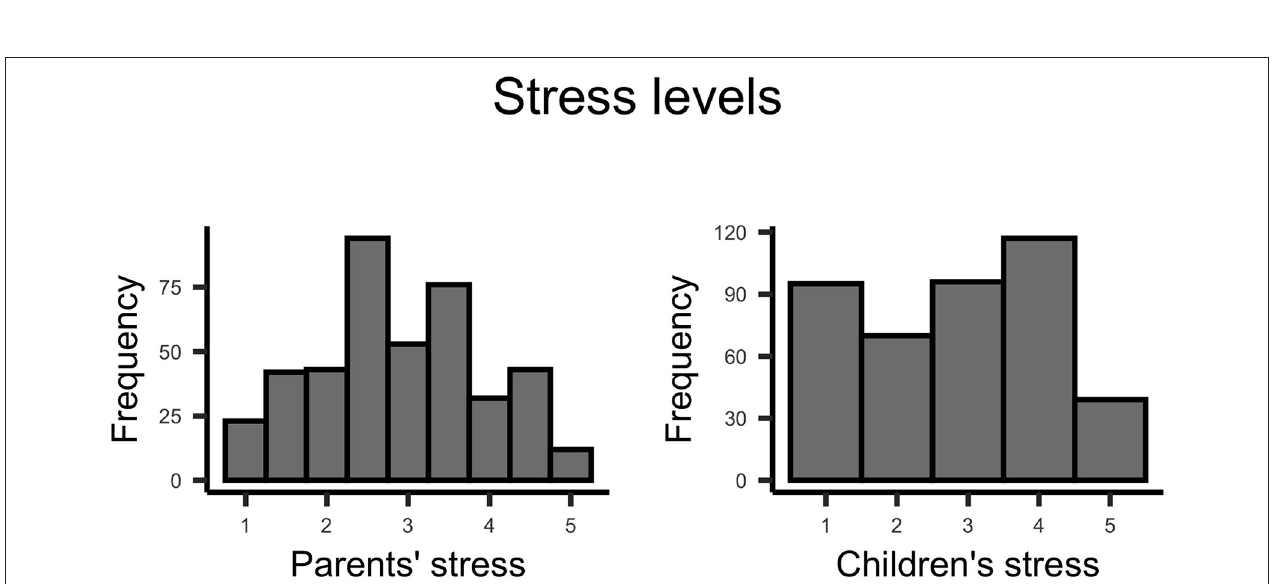
FIGURE 11 | Plots indicate the stress levels of parents and children when taking the